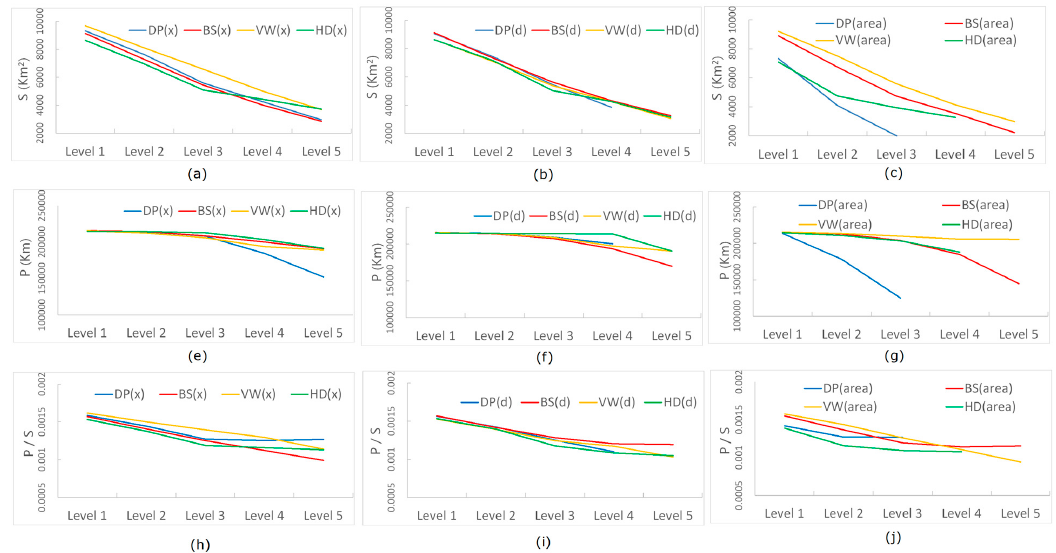
Figure 8. (Color Online) The shape variation of simplified results of the British coastline at five levels of details, indicated by the polygon’s area (Panels a – c ), perimeter (Panels e – g ), and shape factor (Panels h – j ).